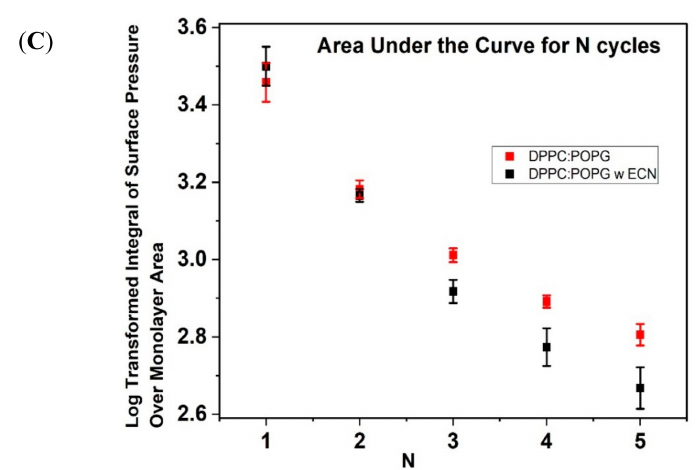
Figure 1. ( A ) Surface Pressure versus area of the trough isotherms for DPPC:POPG (7:3) without (control, red solid line) and with 1 wt.% ECN (black solid line). All samples were compressed and expanded five times. The solid arrows point to the direction of compression curve and the expansion curve on the isotherms. The dashed arrow on the other hand shows the direction of advancement of the compression / expansion cycles. All data has been represented as the mean of 3 samples. ( B ) The initial part of the 4th and 5th compression cycles of DPPC:POPG monolayers with (black lines) and without (red lines) the ECN, showing the lift o ff area for each compression cycle. ( C ) Area under the curve as a function of compression / expansion cycle for DPPC:POPG (7:3) without (control, red square) and with 1 wt.% ECN (black square). A sample size of three was used for finding the log-transformed mean and standard deviation of the